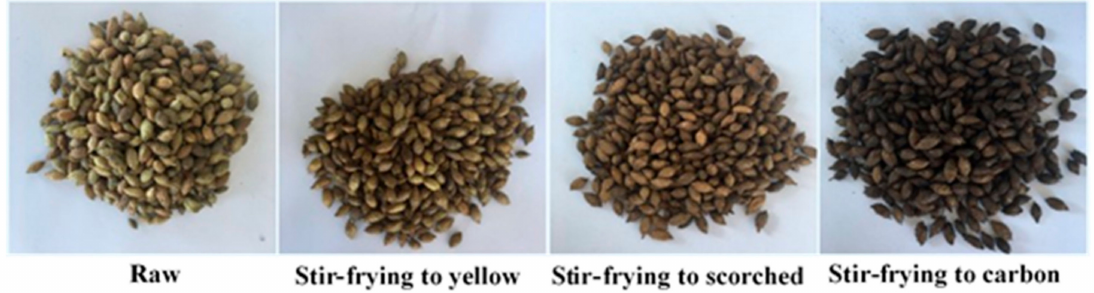
Figure 7. Content (mg/g) of eight components in different forms of XF samples. Data are given as mean ± SD (n =